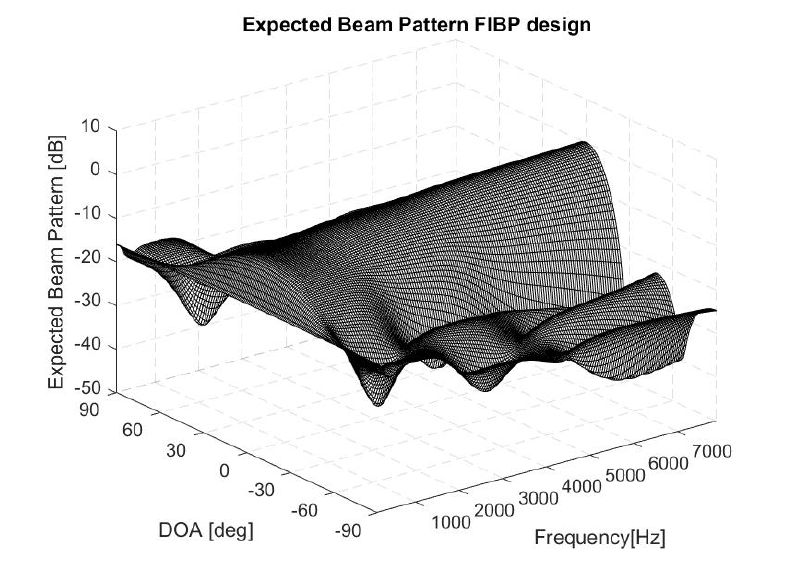
Figure 8. Expected beam pattern FIBP